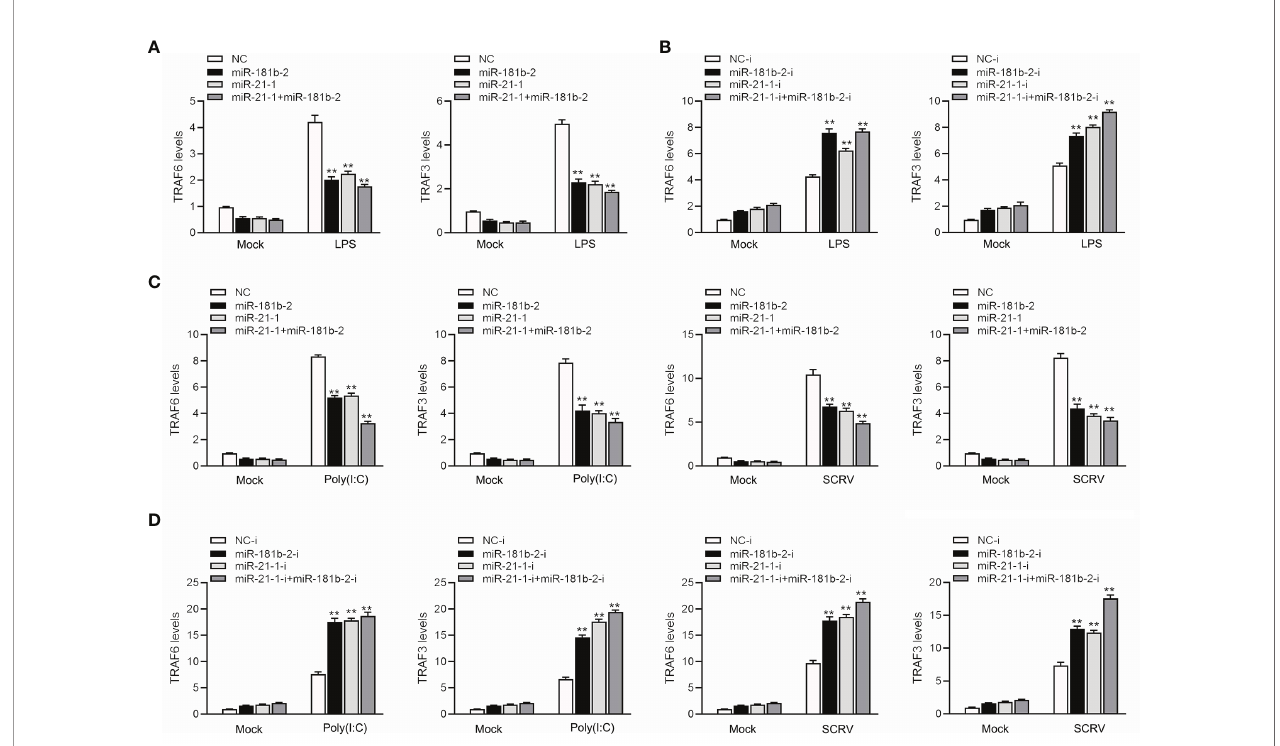
FIGURE 7 | MiR-181b-2 and miR-21-1 regulates the expression of components of the TRIF signaling cascade. (A, B) We transfected NC, miR-181b-2 and miR-21- 1 or NC-i, miR-181b-2-i and miR-21-1-i into MBrC cells for 48 h, then stimulated LPS for 6 h. Afterwards, the expression levels TRAF6 and TRAF3 were determined and normalized to b -actin. (C, D) We transfected NC, miR-181b-2 and miR-21-1 or NC-i, miR-181b-2-i and miR-21-1-i into MBrC cells for 48 h, then poly(I:C) stimulated and SCRV injection. Afterwards, the expression levels TRAF6 and TRAF3 were determined and normalized to b -actin. All data are presented as the means ± SE from three independent triplicate experiments. ** p < 0.01, versus the